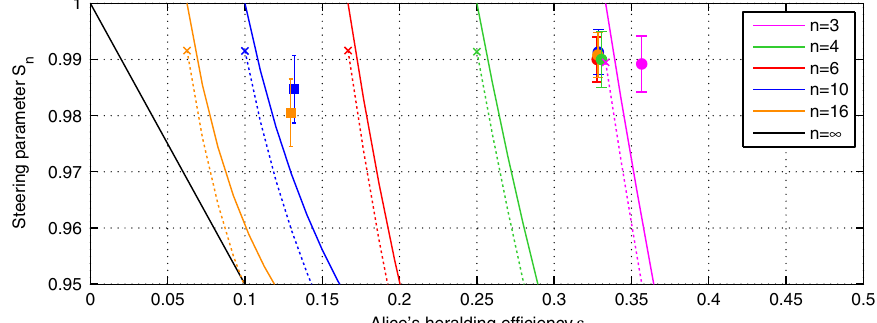
FIG. 5. Experimental demonstration of EPR-steering on an enlarged section of the dashed purple box in Fig. 3, showing the experimental data. The data points show the experimental values for the steering parameter S n obtained for n ¼ 3 , 4, 6, 10, and 16 measurement settings. The d points represent data straight from the entangled source, before the fiber is installed. The j points (for n ¼ 10 and 16 only) represent data collected after the single-mode fiber was installed, demonstrating loss-tolerant EPR-steering with a transmission distance of 1 km. The error bars (1 standard deviation) take into account systematic measurement errors and Poissonian photon-counting noise. The (cid:7) points are experimental cheating data (shown in detail in Fig. 7), from which we derive Alice’s closest approach using a cheating strategy (dashed curves).